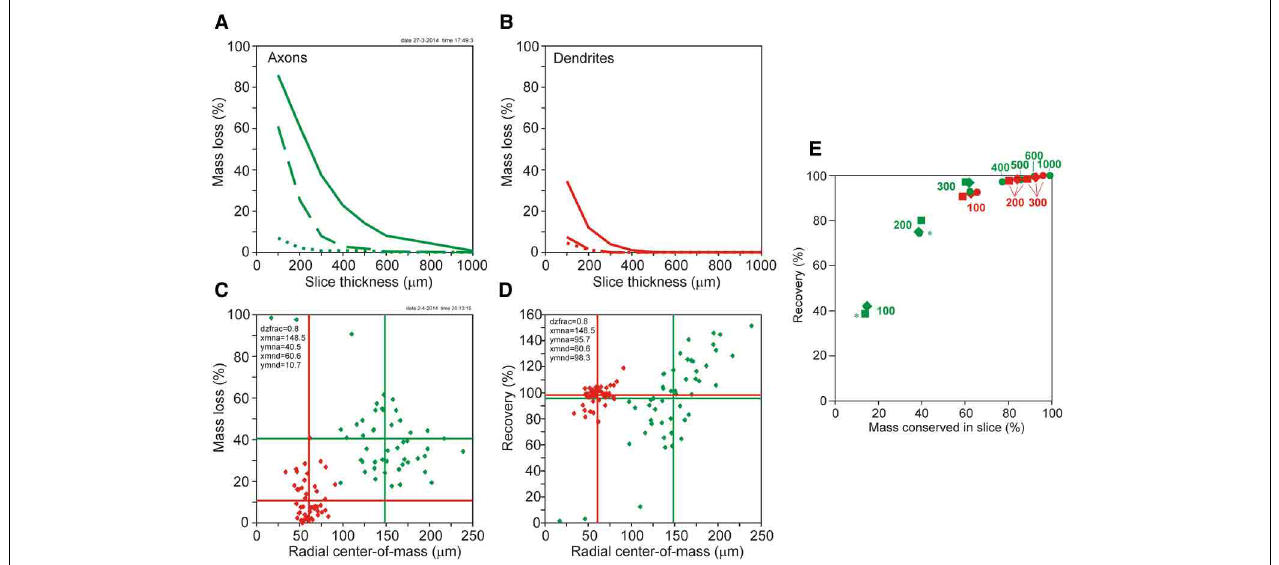
FIGURE 5 | (A,B) Plots of mass loss (%) vs. slice thickness of NETMORPH generated neurons centrally located in the artificial slice. ( A , solid green curve) Lossofaxonalmassbyslicing.( A ,dashedgreencurve)Remainingaxonalmass loss mass after completion without orphan branches. ( A , dotted green curve) Remaining axonal mass loss after completion including orphan branches. ( B , solid red curve) Loss of dendritic mass by slicing of NETMORPH generated neuronscentrallylocatedintheslice.( B ,dashedredcurve)Remainingdendritic mass loss after completion without orphan branches. ( B , dotted red curve) Remaining dendritic mass loss after completion including orphan branches. (C,D) Plots of mass loss by slicing and recovery by completion vs. the mean radial center-of-mass of the sliced axonal and dendritic arborizations. The 50 NETMORPH generated neurons were artificially sliced by 300 μ m thick slices.